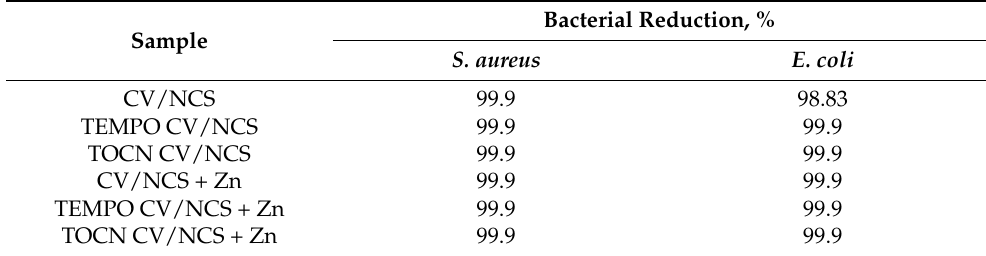
Table 4. The bacterial reduction of NCS and NCS + Zn functionalized viscose fabrics